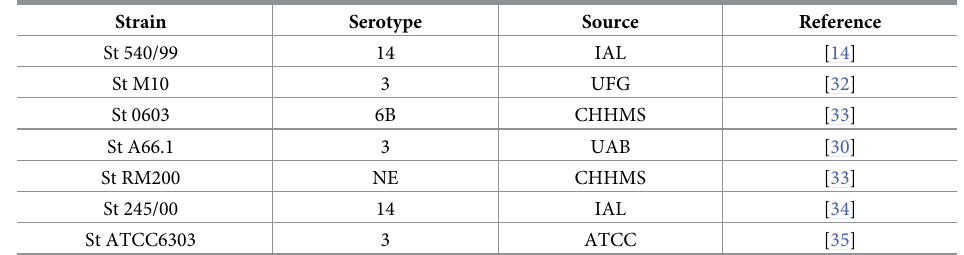
Table 1. Streptococcus pneumoniae strains used in this work.